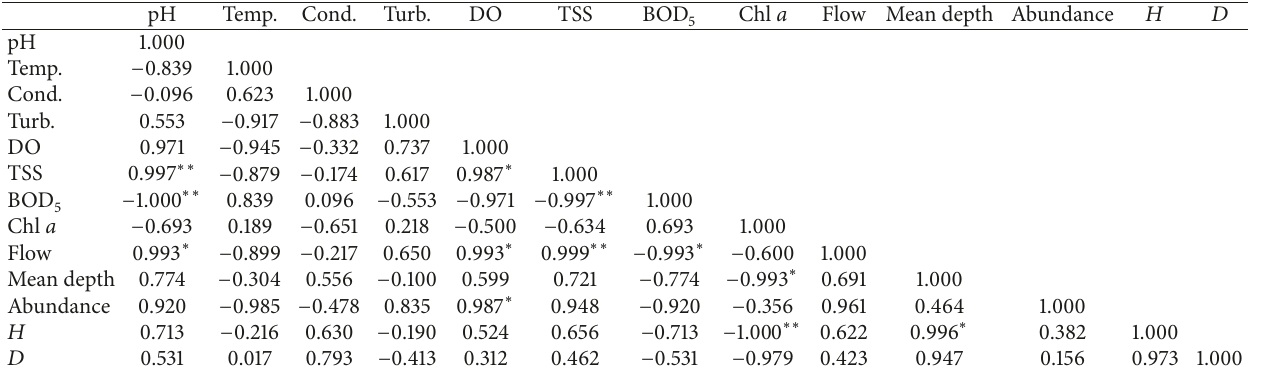
Table 3: Correlation between abiotic and biotic parameters at downstream river of Batang Ai ( 𝑁 = 3 ). pH Temp. Cond.